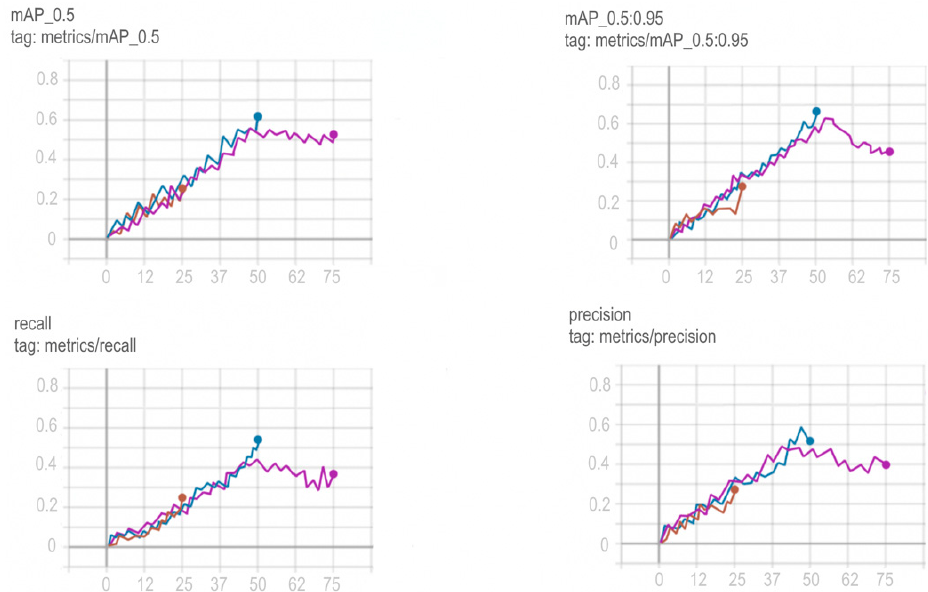
Figure 16. Comparison of training VGG16 at 25 (red graph), 50 (blue graph) and 75 (purple graph) epochs.